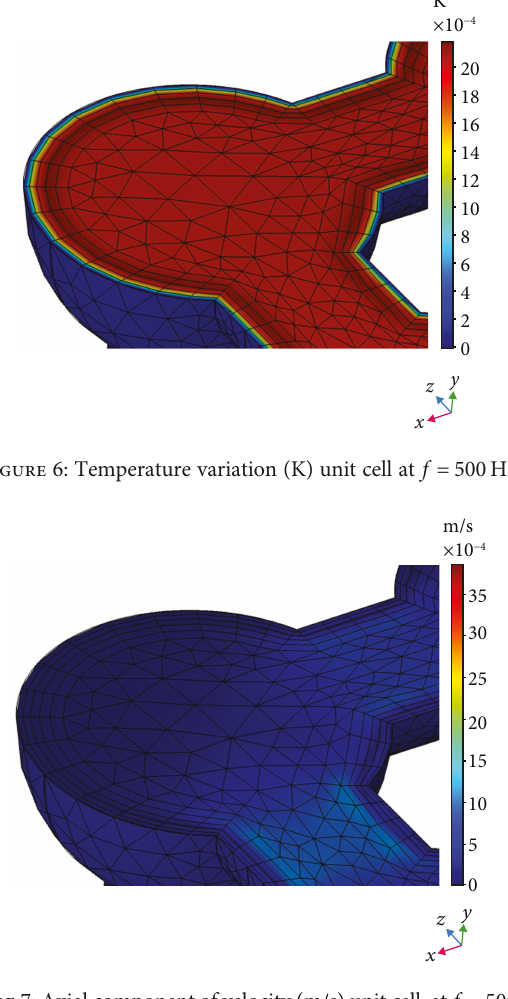
Figure 7: Axial component of velocity (m/s) unit cell, at f = 500 Hz .